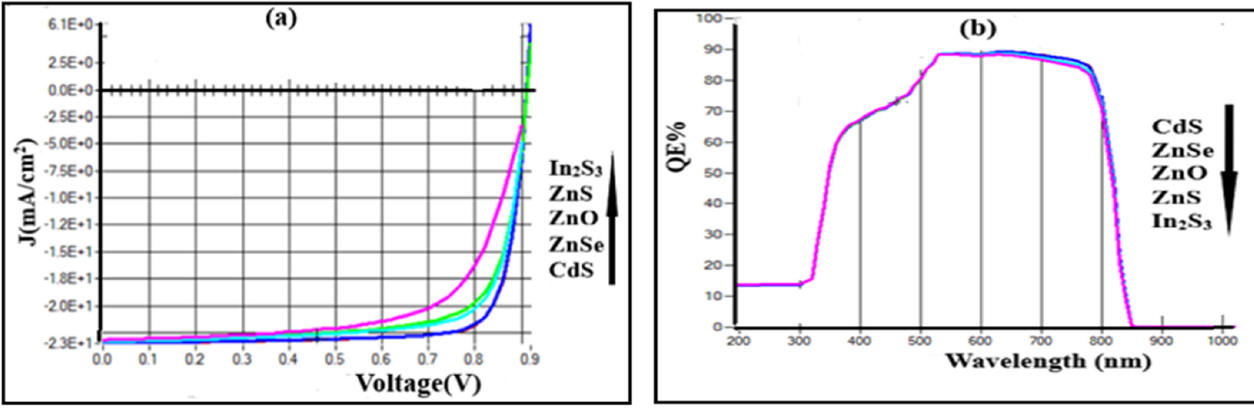
Figure 3. ( a ) J – V current curves for the cell; ( b ) spectral response of solar cells and CdTe layer (acceptor characteristics) with different buffer layer at T = 300 K.